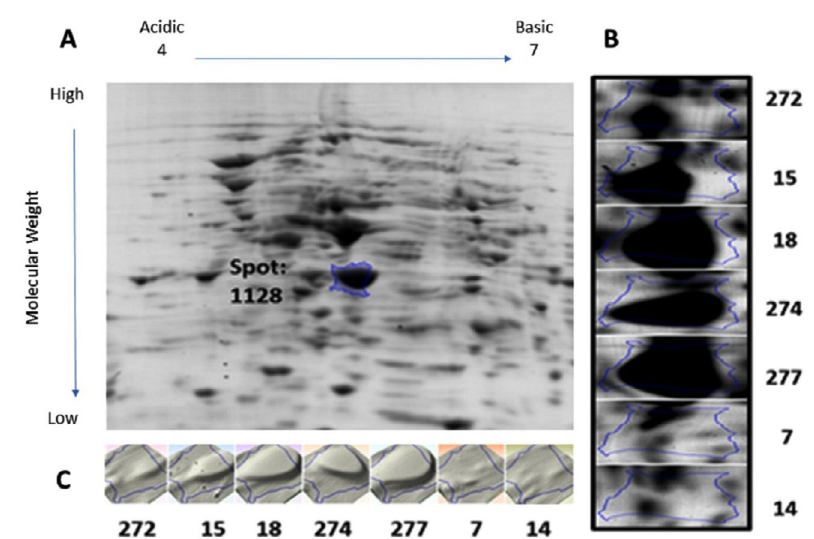
Fig. 1. 2D gel electrophoresis of gel from sample 18 (A). Comparison of spot 1128, identified as OmpA, in all samples (B). 3D montage to visualize the amount of protein in each gel at the same spot